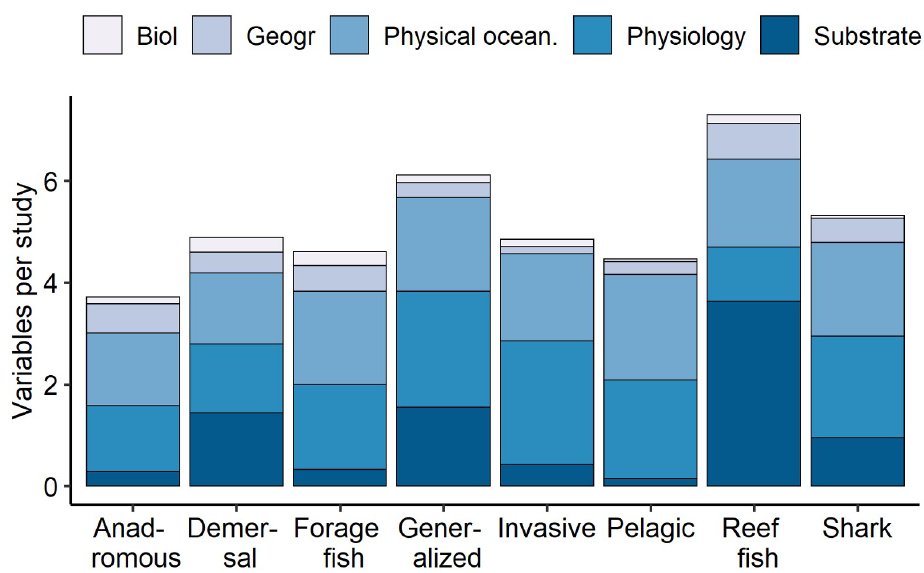
Fig 3. Frequency of predictor variable categories tested by fish guilds. For each fish guild (x-axis), predictor variables were summarized into categories of biological (Biol), geographic (Geogr), physical oceanographic (Physical ocean.), physiology-based oceanographic (Physiology), or substrate ( n =